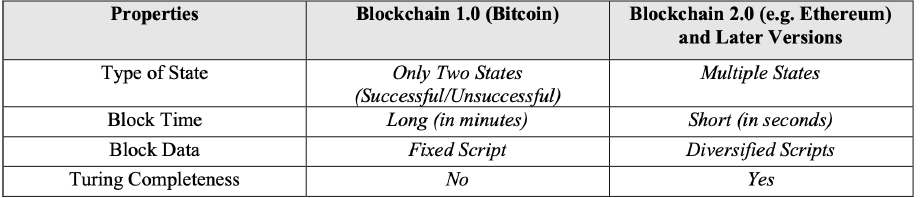
Figure 6. Comparison of Blockchain 1.0 and Blockchain 2.0 (including later